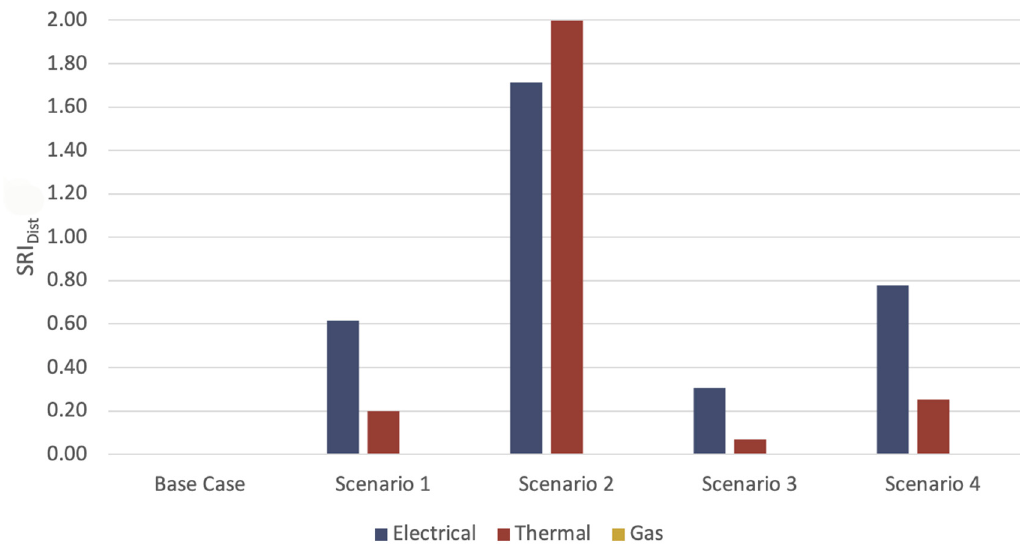
Figure 7. Smart Readiness Indicator District ( SRI Dist ) for the Base Case and Scenarios 1–4.